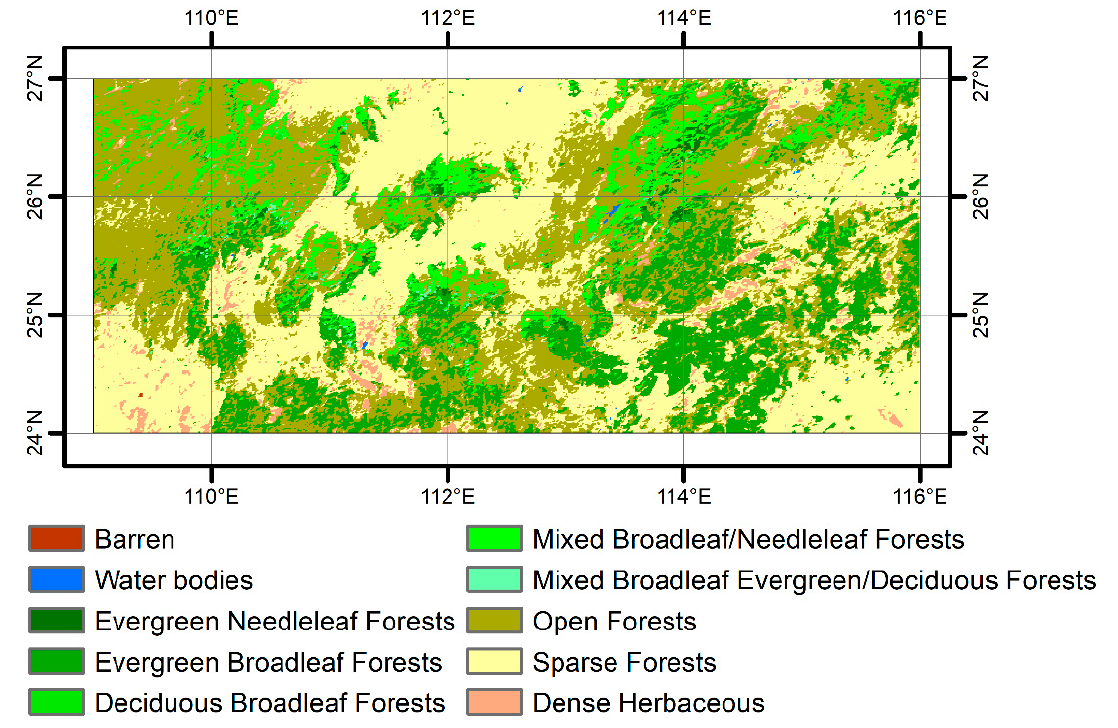
Figure 1. The MCD12Q1 land cover map for the year 2001 with the FAO-Land Cover Classification System 1 over the Nanling Mountains. The presented map has been resampled to 1 km spatial res- olution.